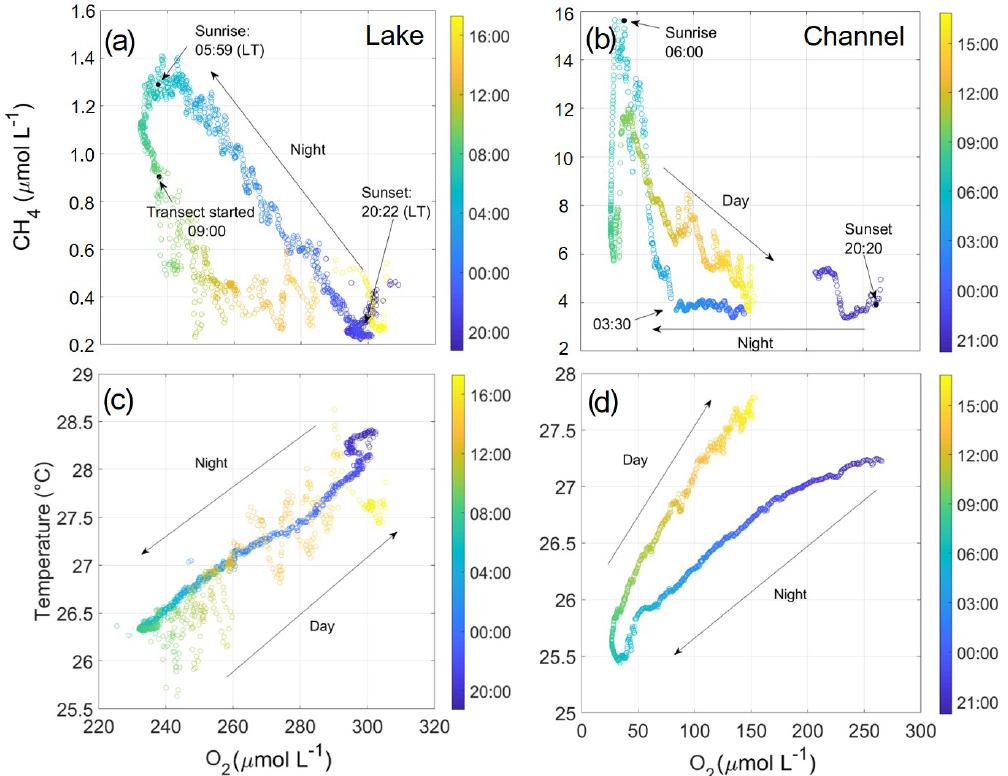
Figure 7. CH 4 (a, b) and temperature (c, d) against O 2 concentration as measured during diel cycle experiments in Lake Ro¸su (a, c) and the hot spot (b, d) . Colour bar denotes time of the day (hh:mm). Sunrise and sunset are also indicated. Both studies were carried out during the August (summer) campaign. During the night from just before 20:00 until 09:00, the boat was anchored and stationary. Transects through the following day continued to map the lake, whereas the channel was all in one anchored